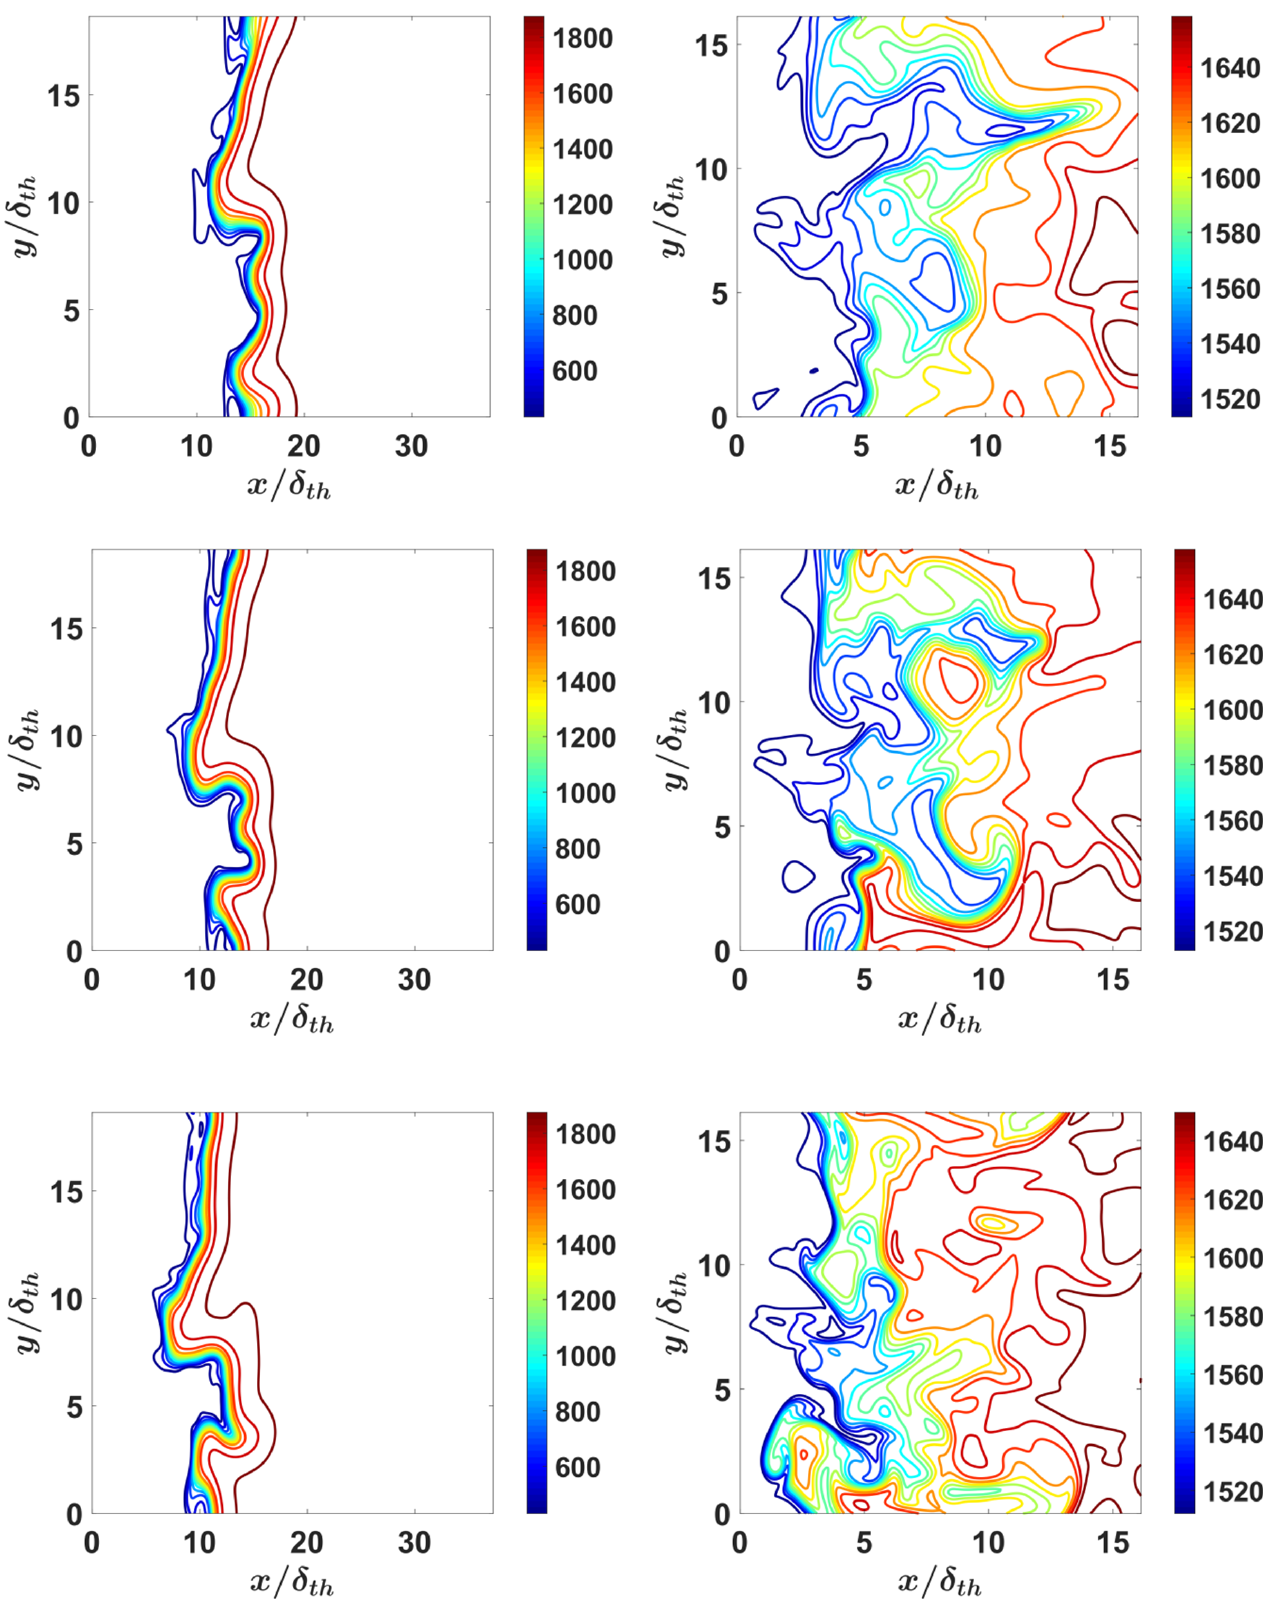
Figure 3. Contours of temperature, T , in the central midplane for statistically planar turbulent premixed flames (first column) and homogeneous MILD combustion cases (second column) for initial u (cid:48) / S L = 4.0, 6.0 and 8.0 (first–third rows).